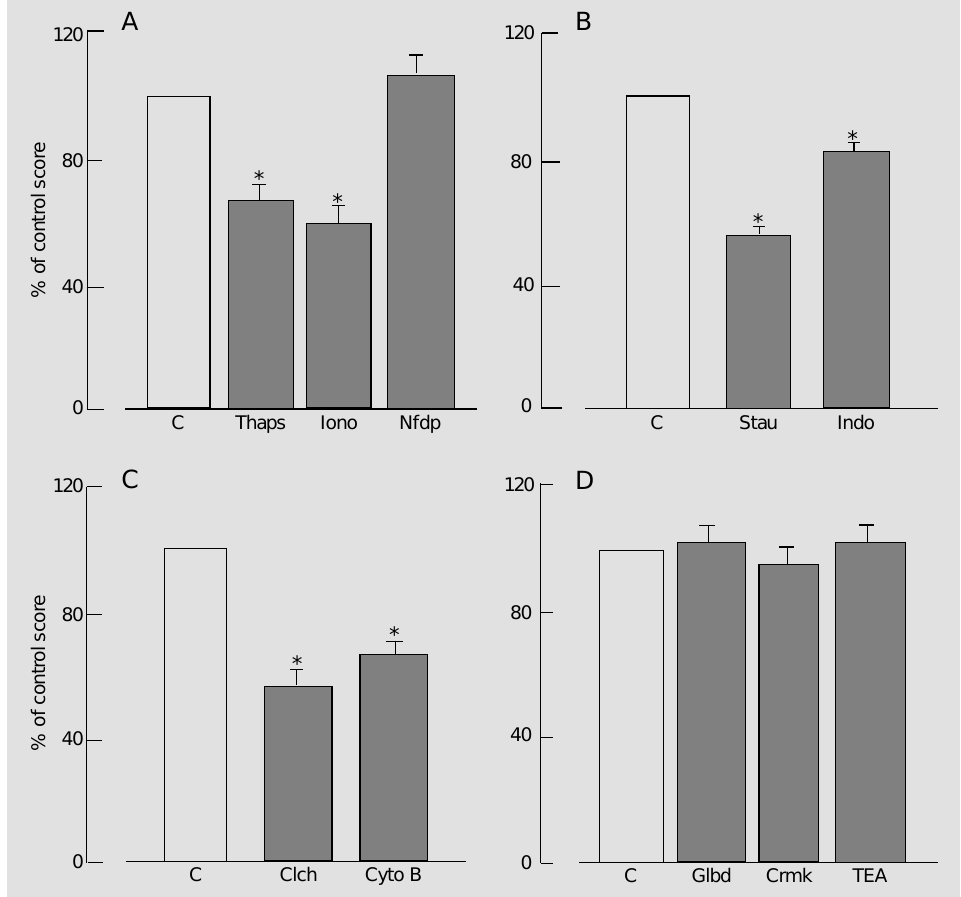
Figure 2 - Effect of different drugs on CaOx crystal endocyto- sis (200 µg/ml, 6 h exposure time) by MDCK cells. Data are reported as percentage of con- trol mean endocytosis scores. The columns represent the mean and the bars the SEM of at least 6 experiments. A , Thap- sigargin (Thaps, 1 µM), ionomy- cin (Iono, 100 nM) and nifedi- pine (Nfdp, 10 nM). *P<0.005 compared to control (C) (Student t -test). B , Staurosporine (Stau, 10 nM) and indomethacin (Indo, 3 µM). *P<0.05 compared